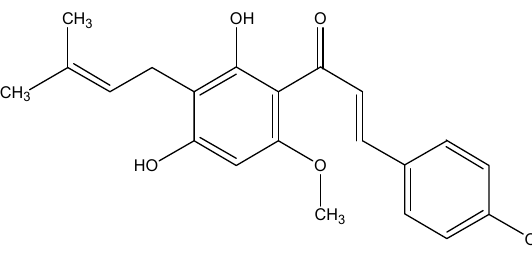
Figure 2. The chemical structure of xanthohumol.